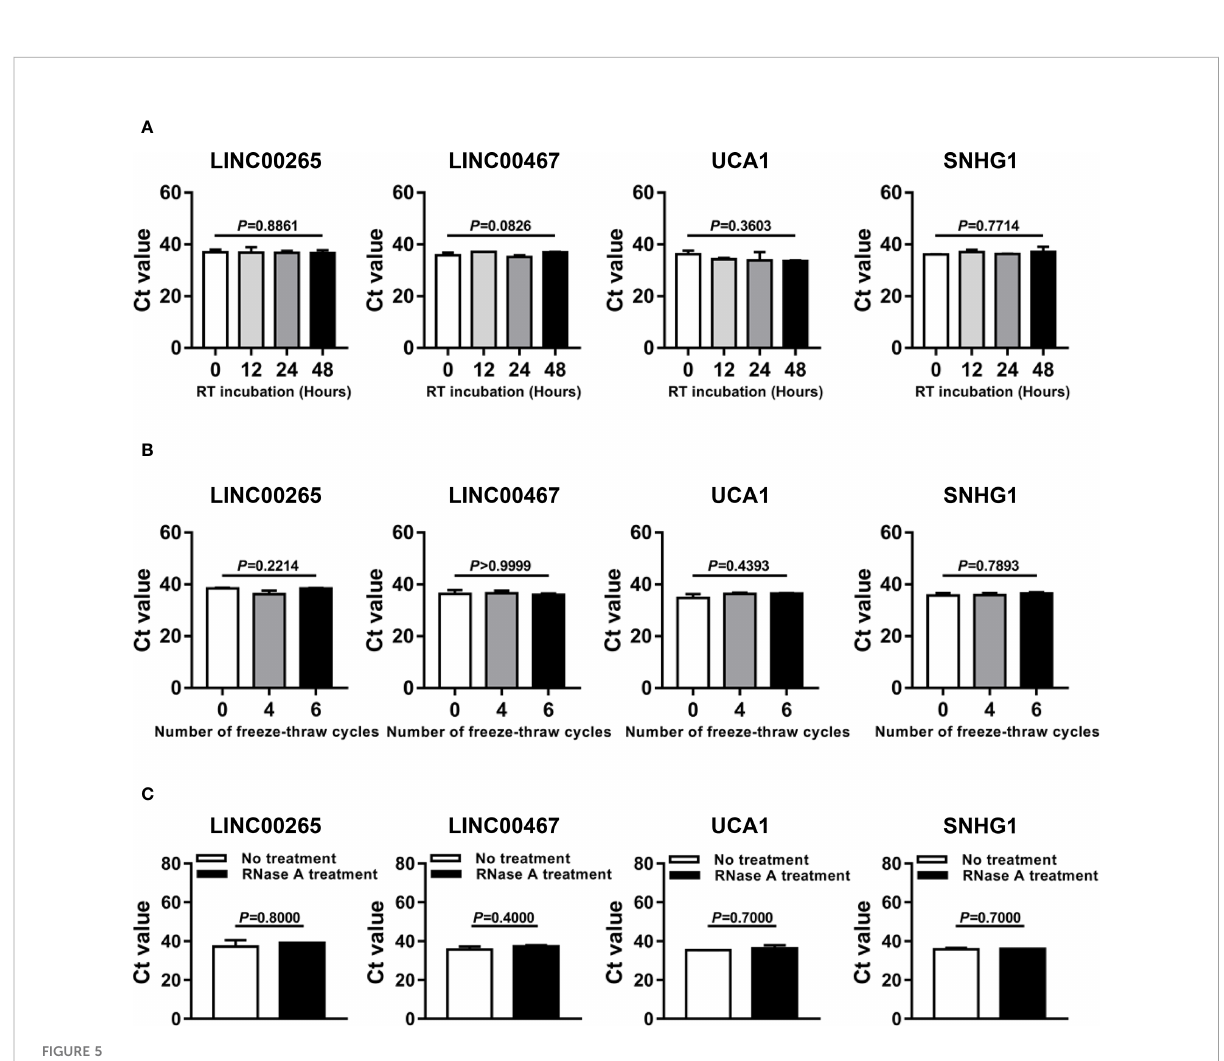
FIGURE 5 Stability Evaluation of the Dysregulated LncRNAs in Plasma Exosomes. (A) Aliquots of plasma exosome suspensions isolated from the AML patient were incubated at room temperature (RT) for 0, 12, 24, and 48 h, respectively. qRT-PCR analysis of the threshold cycle (Ct) value of four plasma exosomal lncRNAs (LINC00265, LINC00467, UCA1, and SNHG1) in the pretreated suspensions. The Shapiro-Wilk normality test and Brown-Forsythe test were performed to test normality and homogeneity of variance, and then the Kruskal-Wallis test was used to compare differences among four groups and determine P values. (B) Aliquots of plasma exosome suspensions isolated from the AML patient were subjected to freeze-thaw for 0, 4, and 6 cycles at -80 °C, respectively. qRT-PCR analysis of the Ct value of four plasma exosomal lncRNAs (LINC00265, LINC00467, UCA1, and SNHG1) in the pretreated suspensions. The Shapiro-Wilk normality test and Brown-Forsythe test were performed to test normality and homogeneity of variance, and then the Kruskal-Wallis test was used to compare differences among